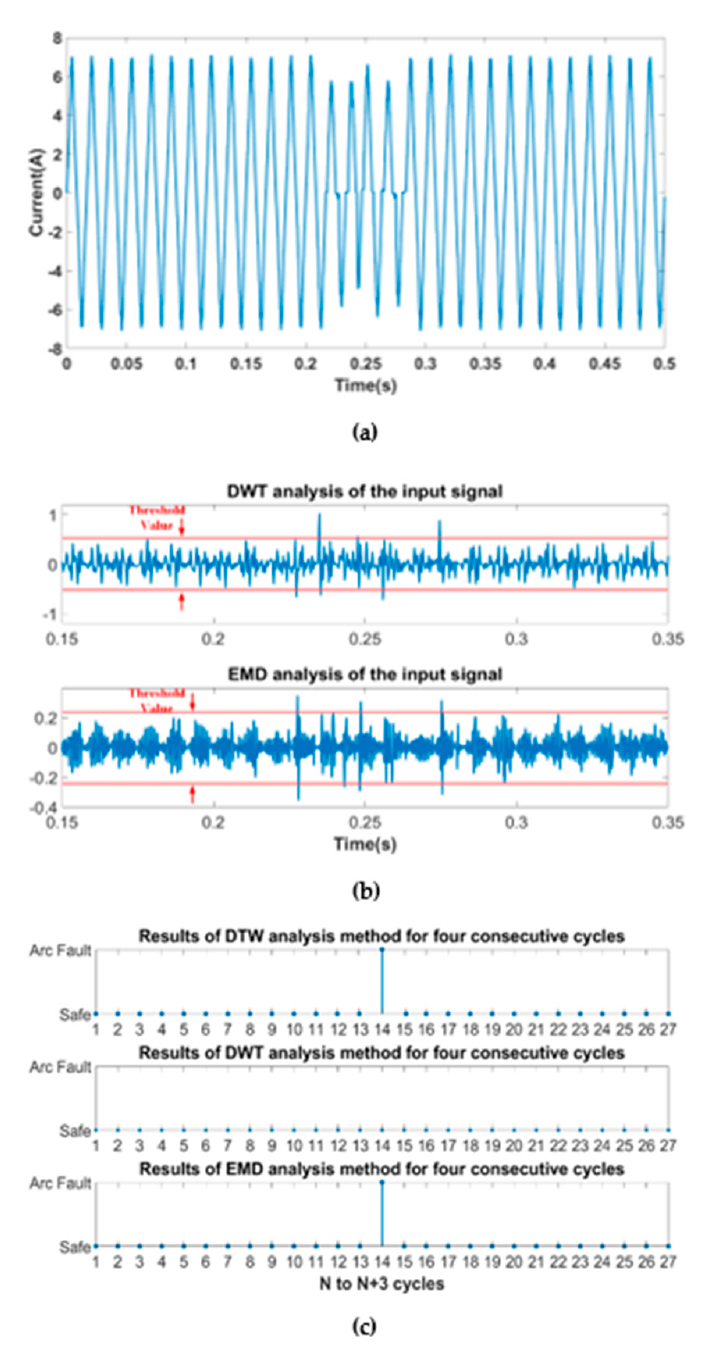
Figure 14. Series arc fault detection results of the vacuum cleaner load ( a ) input current signal, ( b ) DWT and EMD analysis signals, and ( c ) the detection result of each method.